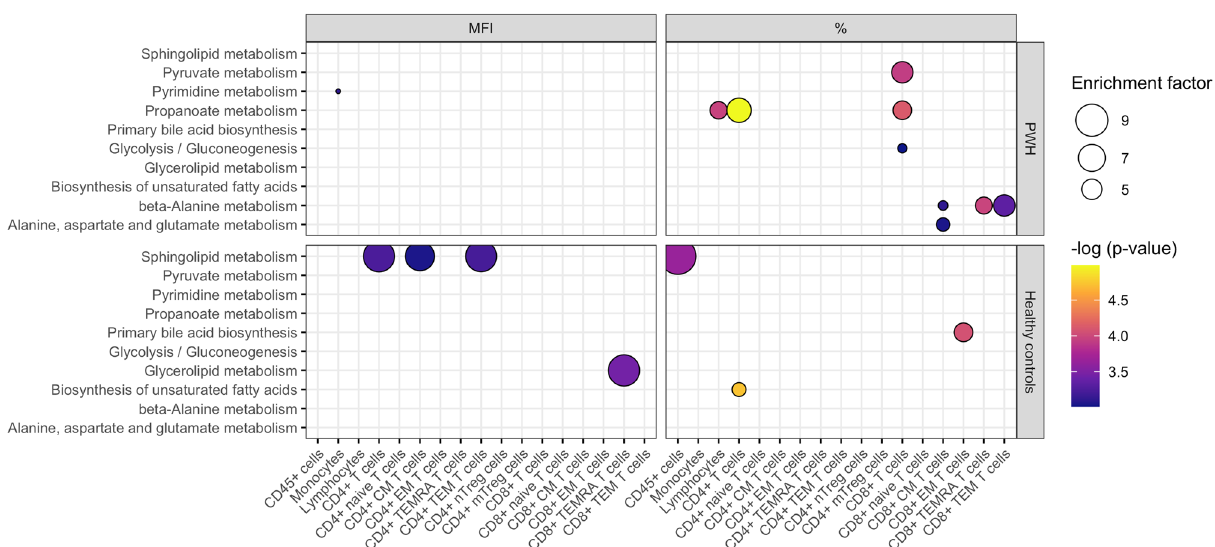
Figure 5. Metabolic pathways associated to CCR5 expression (MFI left panels, % right panels) from various immune cell subsets. CCR5 expression was measured as MFI (left panels) and percentage of CCR5+ cells (%, right panels)). The upper panels show results for PLHIV, whereas the lower panels show the results from controls. The colour of the circles depicts the significance of the association between pathways and CCR5 expression. The size of the circles depicts the enrichment factor, which refers to the ratio between the number of significant pathway hits and the expected number of compound hits within the pathway (no cut-off value). Unadjusted p values are presented, with a cut-off < 0.001 being used for the selection of the